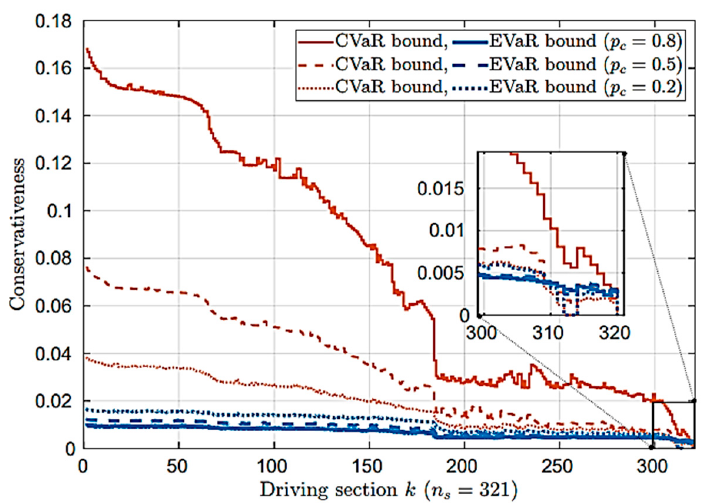
Figure 14. Values of the conservatively index of the CVaR and EVaR boundary determined in [21] for p c = 0.2, 0.5, 0.8.